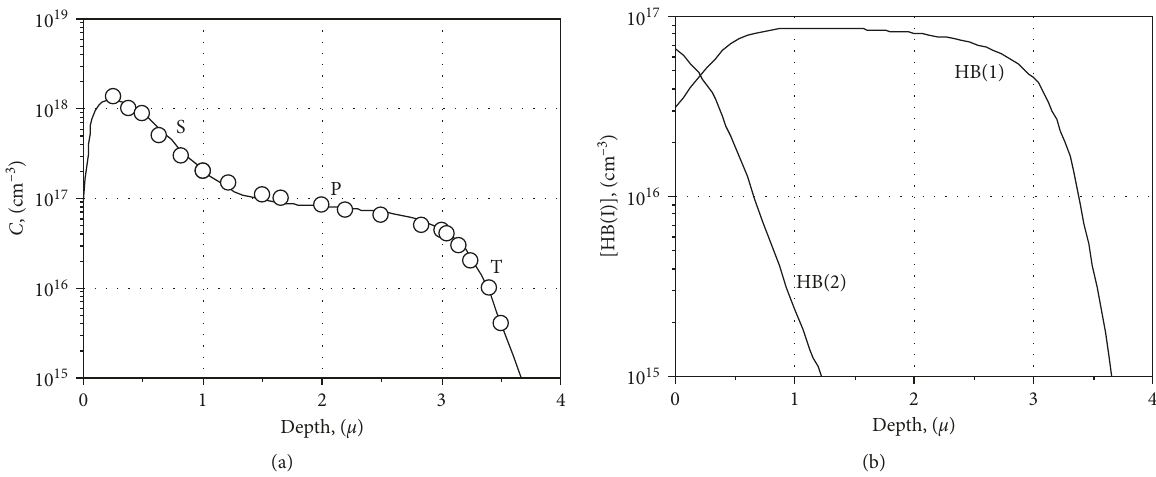
17 cm 3 annealed at 150 ° C for 30 min [11]. (a) Total concentration due to boron B (cid:28) 10 −